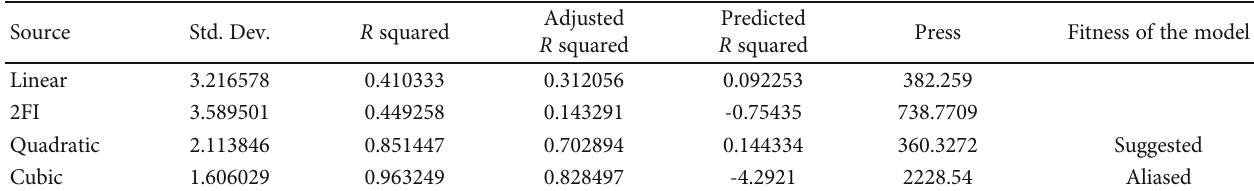
Table 5: Evaluation of di ff erent models to fi t response value using statistical